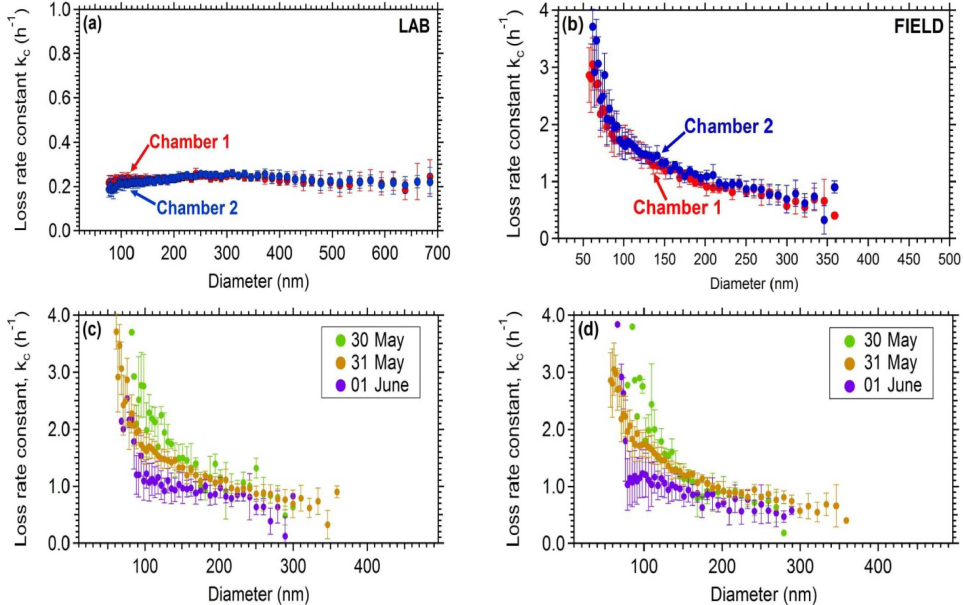
Figure 4. Coagulation-corrected particle wall loss rate constant as a function of particle size for the two chambers (a) in the laboratory and (b) in the field. The particle wall loss rate constant as a function of particle size during 3 consecutive days for the field deployment. Panel (c) corresponds to chamber 1 and (d) to chamber 2.